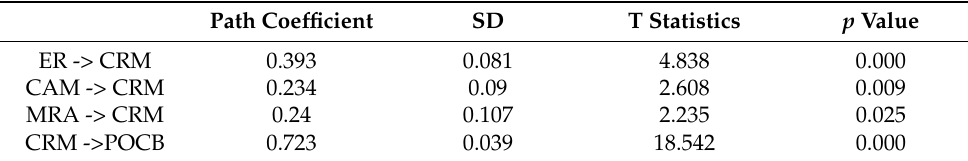
Table 7. Path coefficient and hypotheses testing.